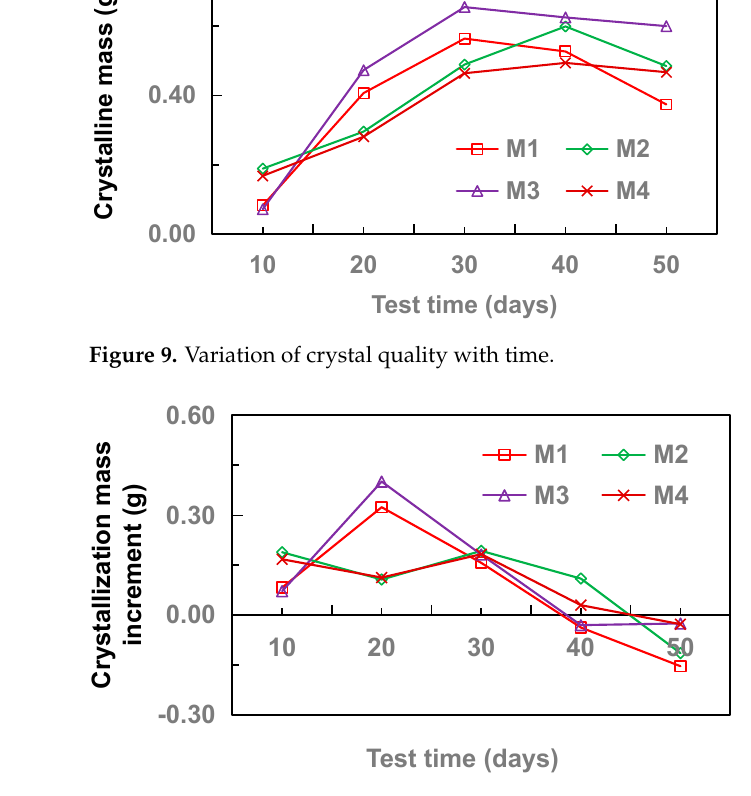
Figure 10. Variation of crystal mass increment with time.